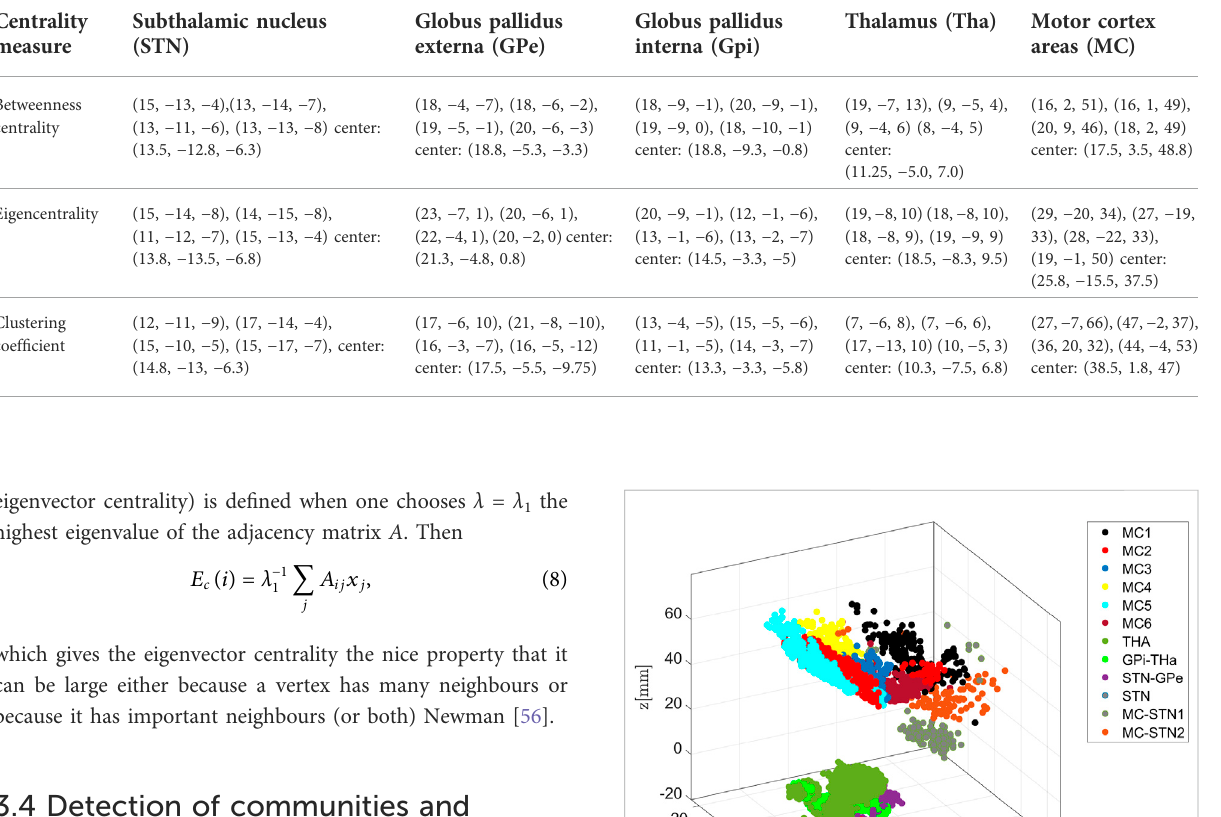
TABLE 1 High centrality nodes, which might have high effectiveness in the DBS treatment.